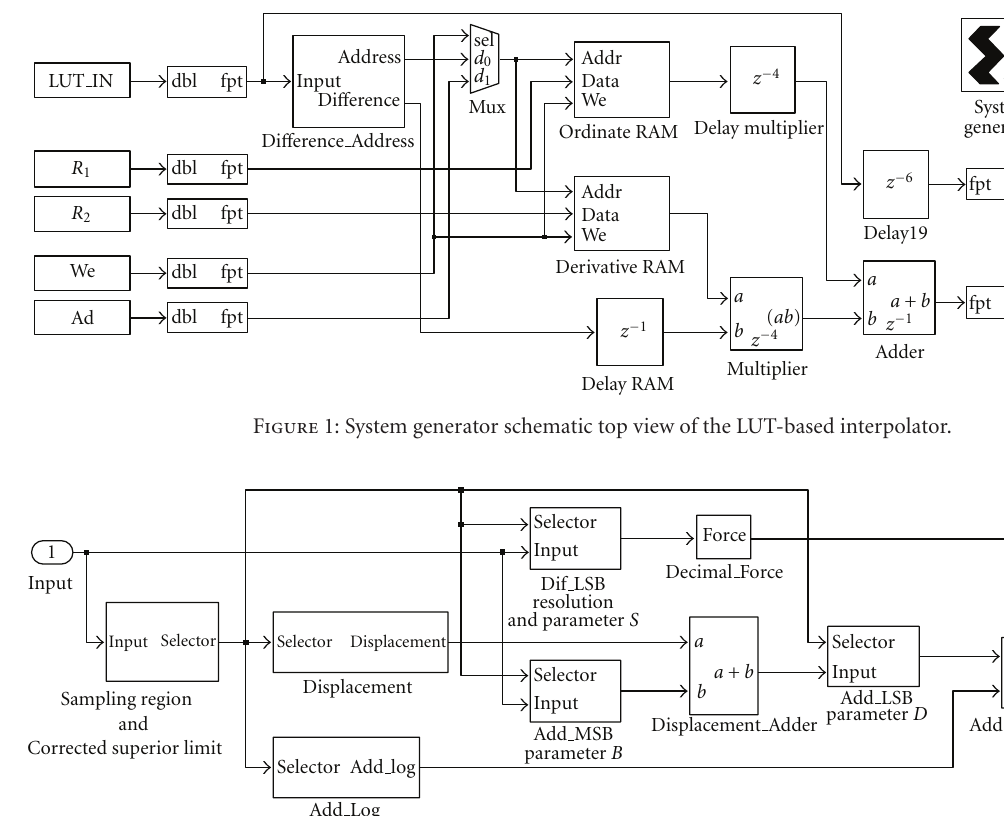
Figure 2: System generator schematic view of Di ff erence Address